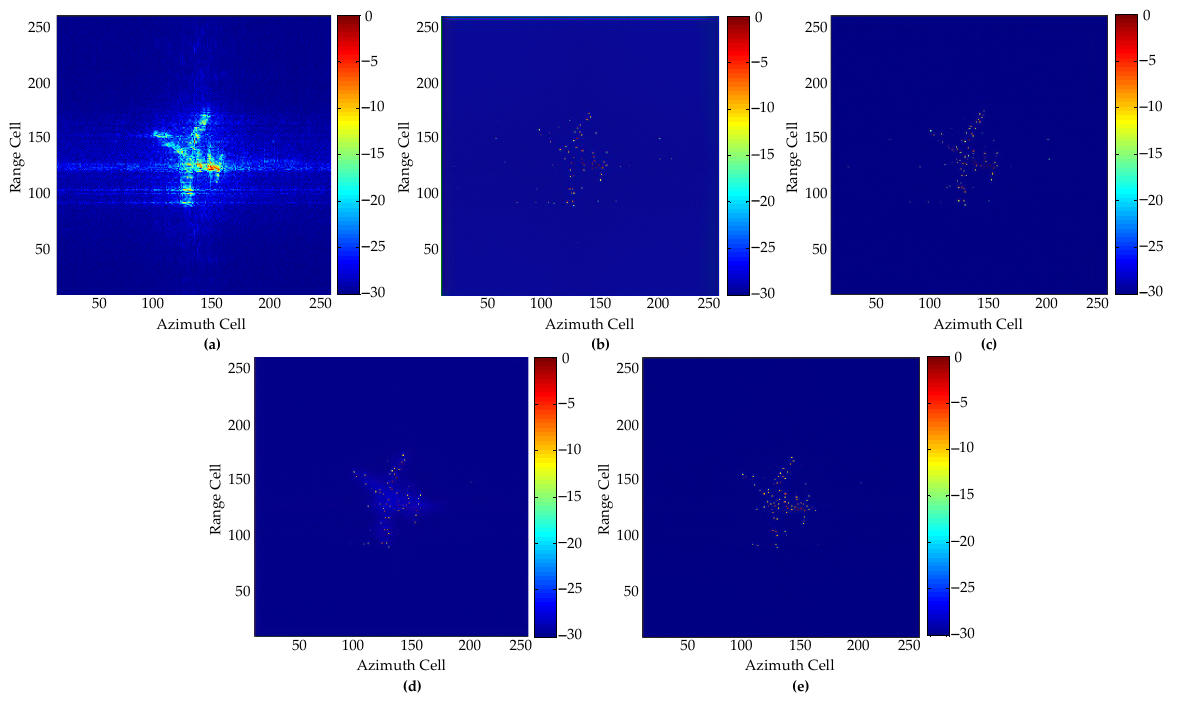
Figure 6. Imaging results of Yak42 under the condition of no noise and full aperture: ( a ) IFFT; ( b ) GAN1; ( c ) GAN2; ( d ) GAN3; ( e ) Proposed GAN. Table 2. Numerical performance evaluation for Yak42 under ideal environment.